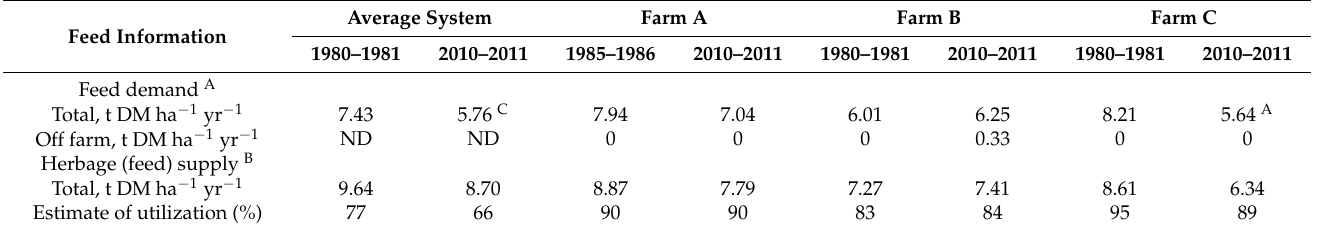
A Including feed demand of grazing in dairy cattle; theoretically Feed demand = Herbage harvested, which was calculated using the Excel MEB model. B Herbage supply was derived using the GROW model. C Including feed demand of grazing-in dairy cattle. Average System = B+LNZ Class IV, medium slope, New Zealand southern North Island hill country sheep and beef cattle production systems as calculated in this study. ND = Not determined, because stock carried off farm was not reported in the annual farm